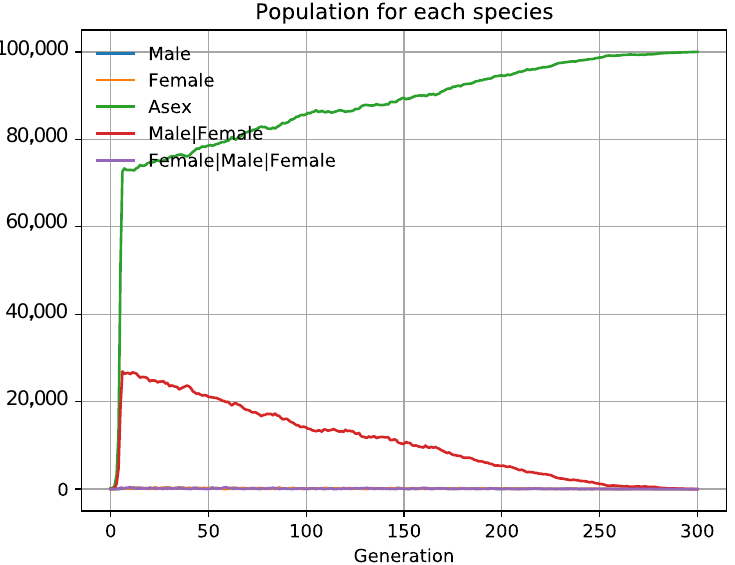
Figure 8. In polygamy, asexual organisms also prevail (data obtained from 1Sex3.json in Supple- mentary Materials). In groups that work the same way as associations, a male can partner, forming a group with only females (Male|Female) or two (Female|Male|Female). Under the same initial conditions, ceteris paribus, asexual populations prevail and extinguish sexual partners as happened in systems of monogamous associations. Only females can reproduce, and due to sampling errors, fluctuations in female populations can decrease the biotic potential of sexual populations over that of asexual ones, where they all have offspring.